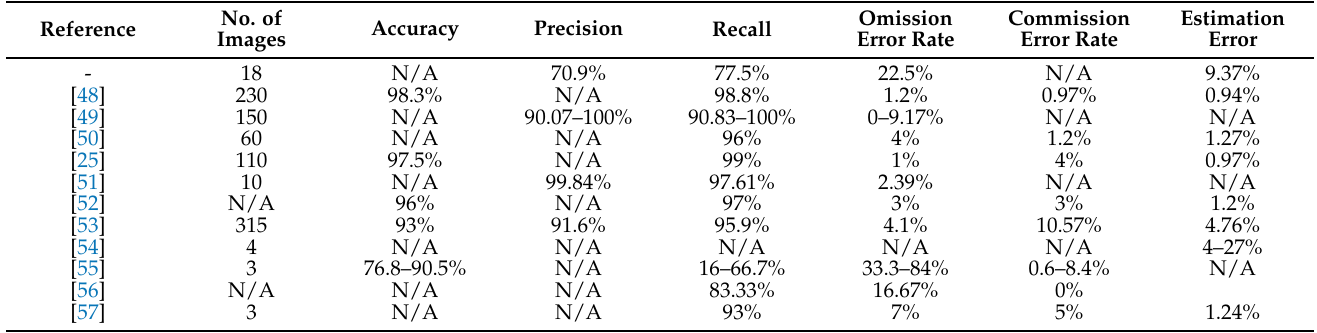
Table 6. Comparison of the results of this study with the results of other closely related articles that, although they do not explicitly use images of groves with thick plant cover on the ground, deal with the detection or segmentation of the olive tree canopies. The article reference, how much data is used (no. of images) and what quality metrics are achieved (accuracy, precision, recall, omission error, commission error and estimation error) are